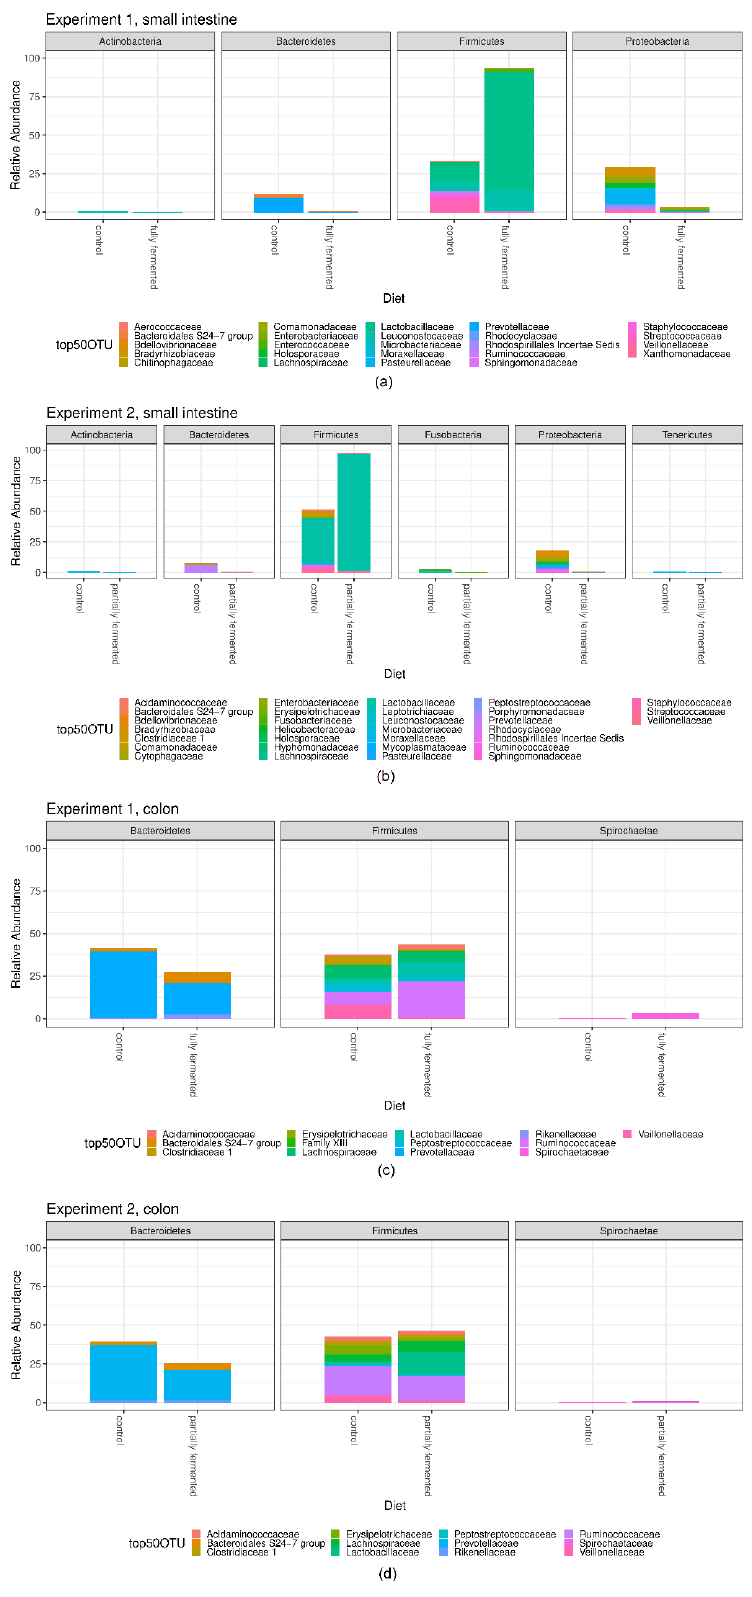
Figure 3. Relative abundance of the 50 most abundant operational taxonomic units (OTUs) belonging to the bacterial families within the di ff erent phyla in ( a ) Experiment 1, small intestine; ( b ) Experiment 2, small intestine; ( c ) Experiment 1, colon, and ( d ) Experiment 2,